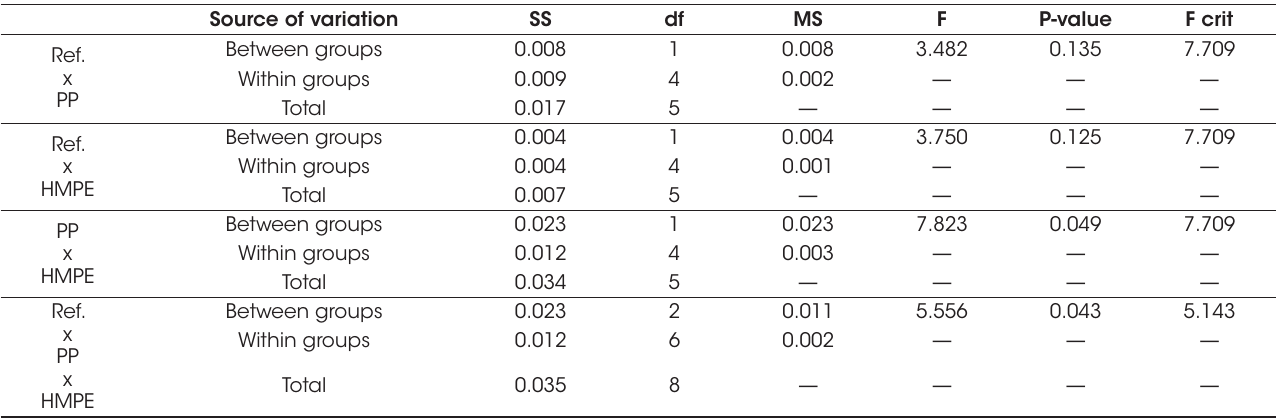
Statistical analysis of variance (ANOVA, p<0.05) for thermal conductivity coefficient, between reference concrete (Ref.), PP fiber concrete (PP) and HMPE fiber concrete